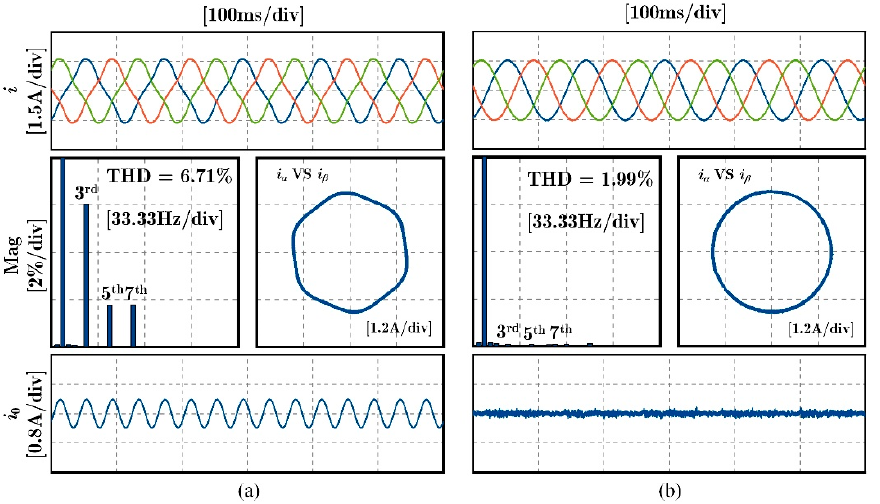
Figure 12. Simulation performance under steady-state: ( a ) comparison scheme (without zero-sequence loop control); ( b ) proposed scheme (with zero-sequence loop control).